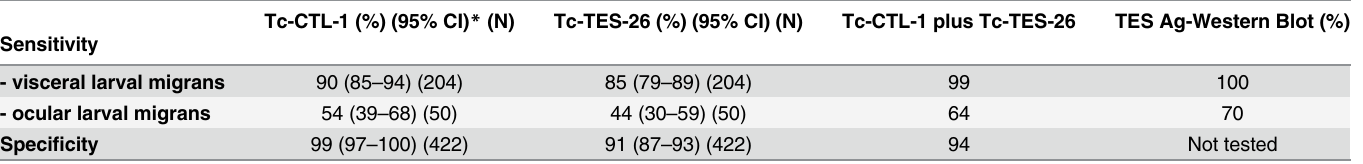
Table 3. Performance of Tc-CTL-1 and Tc-TES-26 Luminex based assays.